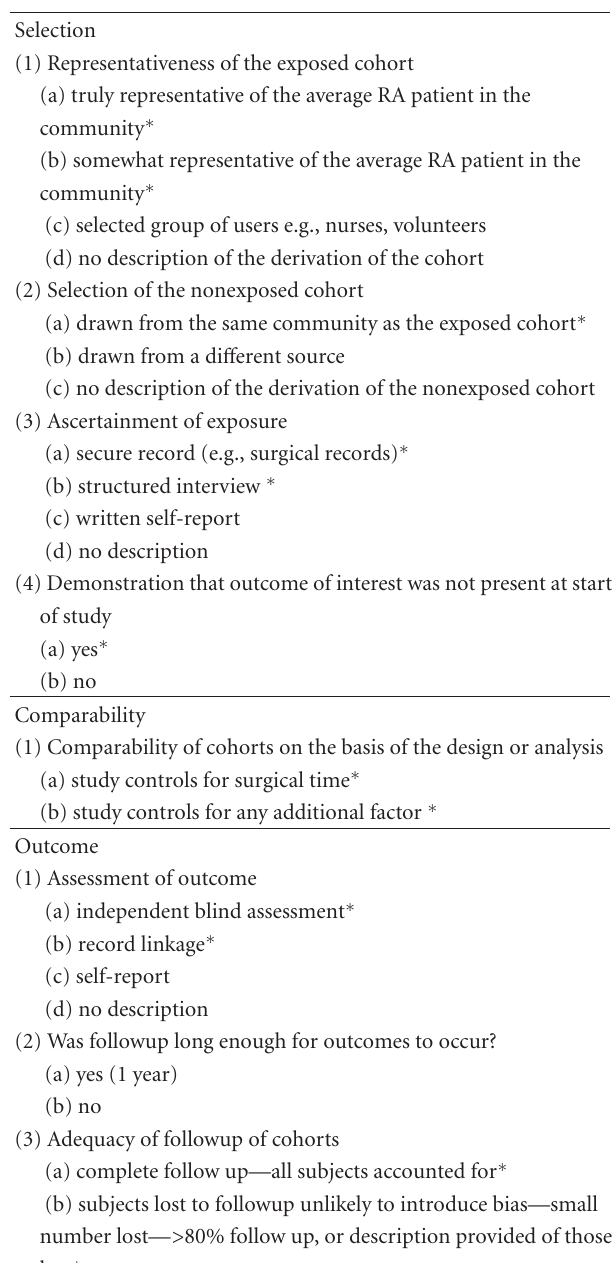
Table 1: Newcastle-Ottawa Cohort Quality Assessment Scale, adapted for review purposes, as description from authors. Acronym: RA: rheumatoid